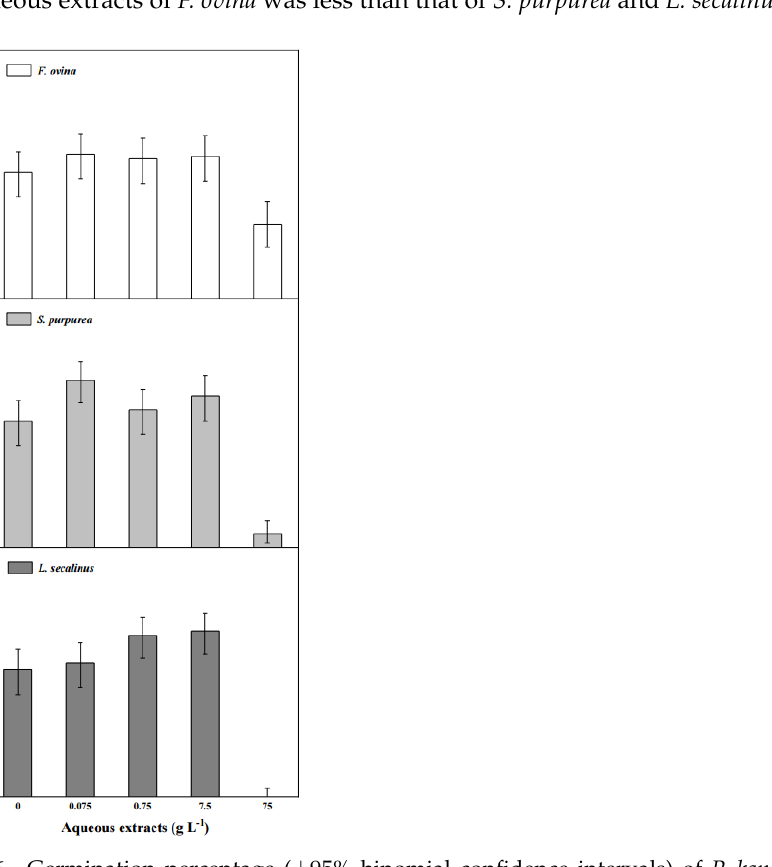
The germination of the P. kansuensis seeds was significantly affected by the aqueous extracts of the native dominant perennial grasses. With the increase in the aqueous extract concentrations of the native grasses, the seed germination percentages first increased and then decreased (Figure 6). The seed germination of P. kansuensis was almost completely inhibited at the 75 g L − 1 concentration of the S. purpurea and L. secalinus extracts and the germination percentages were 6% and 0%, respectively. In addition, the inhibition effect of the aqueous extracts of F. ovina was less than that of S. purpurea and L. secalinus .